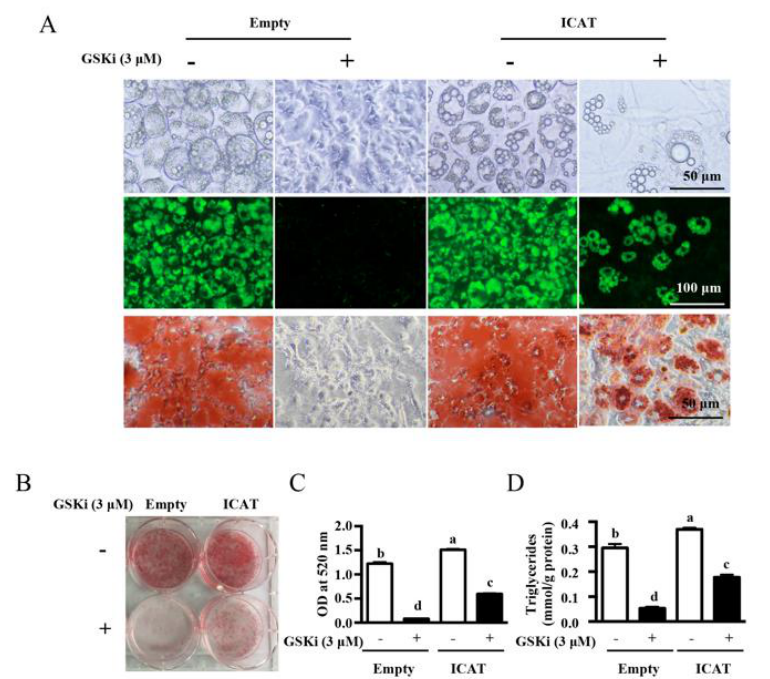
Figure 4. Overexpression of ICAT reversed the effect of GSK3β inhibitor on cell differentiation and adipogenesis in 3T3-L1 adipocytes. Cells were treated as in Figure 3 and were collected after 7-day differentiation. ( A ) Representative micrographs of adipocytes stained with or without BODIPY493/503 (green) and oil red O (red). ( B ) Photograph of adipocytes stained with oil red O (red). ( C ) Lipid contents and ( D ) TG contents of 3T3-L1 adipocytes. Values are means ± SEMs, n = 3 independent experiments. Means without a common letter differ, p < 0.05. GSKi, CHIR99021; ICAT, Inhibitor of β-catenin and TCF4.